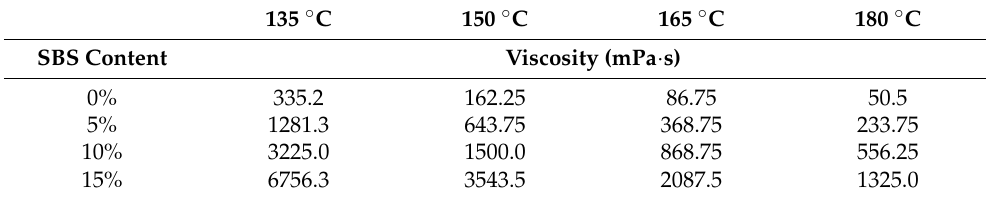
Table 4. Viscosity values for PG 64-22 with 6% processed oil as a function of the SBS content and temperature.